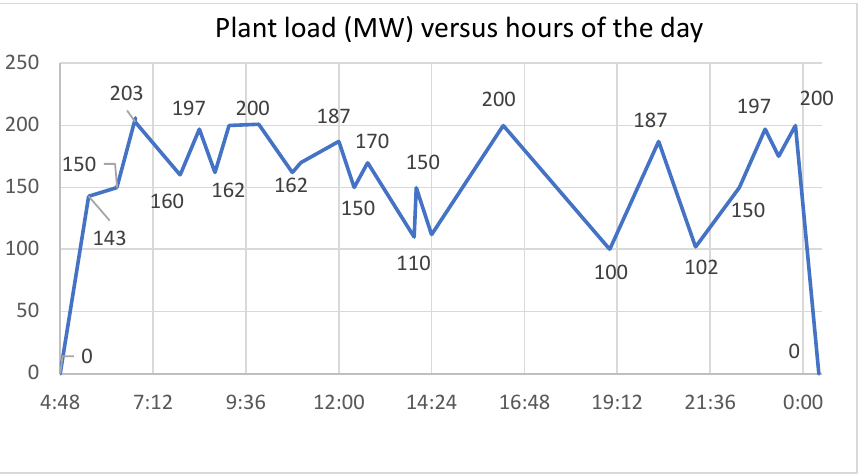
Figure 7 . Example of a combined cycle power plant flexible operation. Adapted from Ref. [58]. Figure 7. Example of a combined cycle power plant flexible operation. Adapted from Ref.